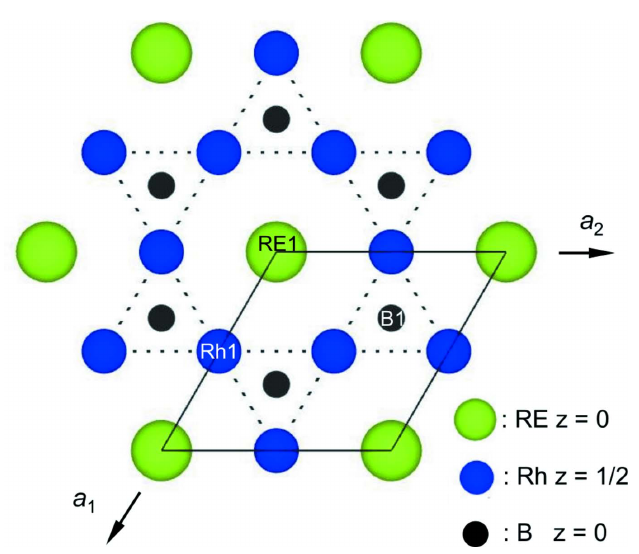
Figure 2 Unit-cell parameters a (circles), c (squares) and unit-cell volume (triangles) of RE Rh 3 B 2 compounds. Closed and open marks refer to this study and previous work (Malik et al. , 1983),